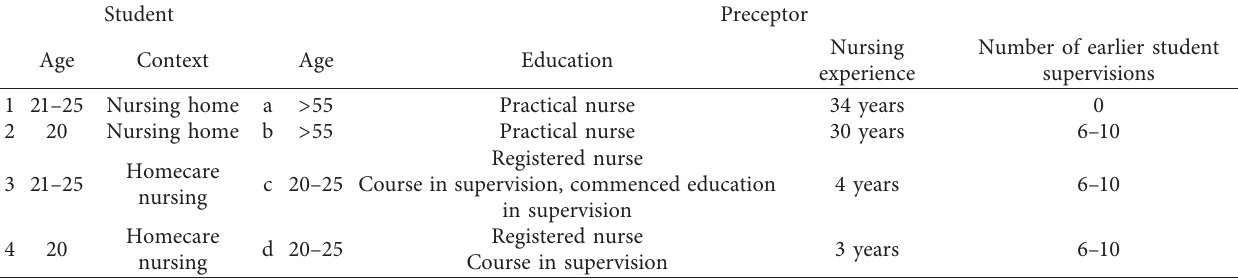
Table 1: Students (1–4) and preceptors (a–d) together in different